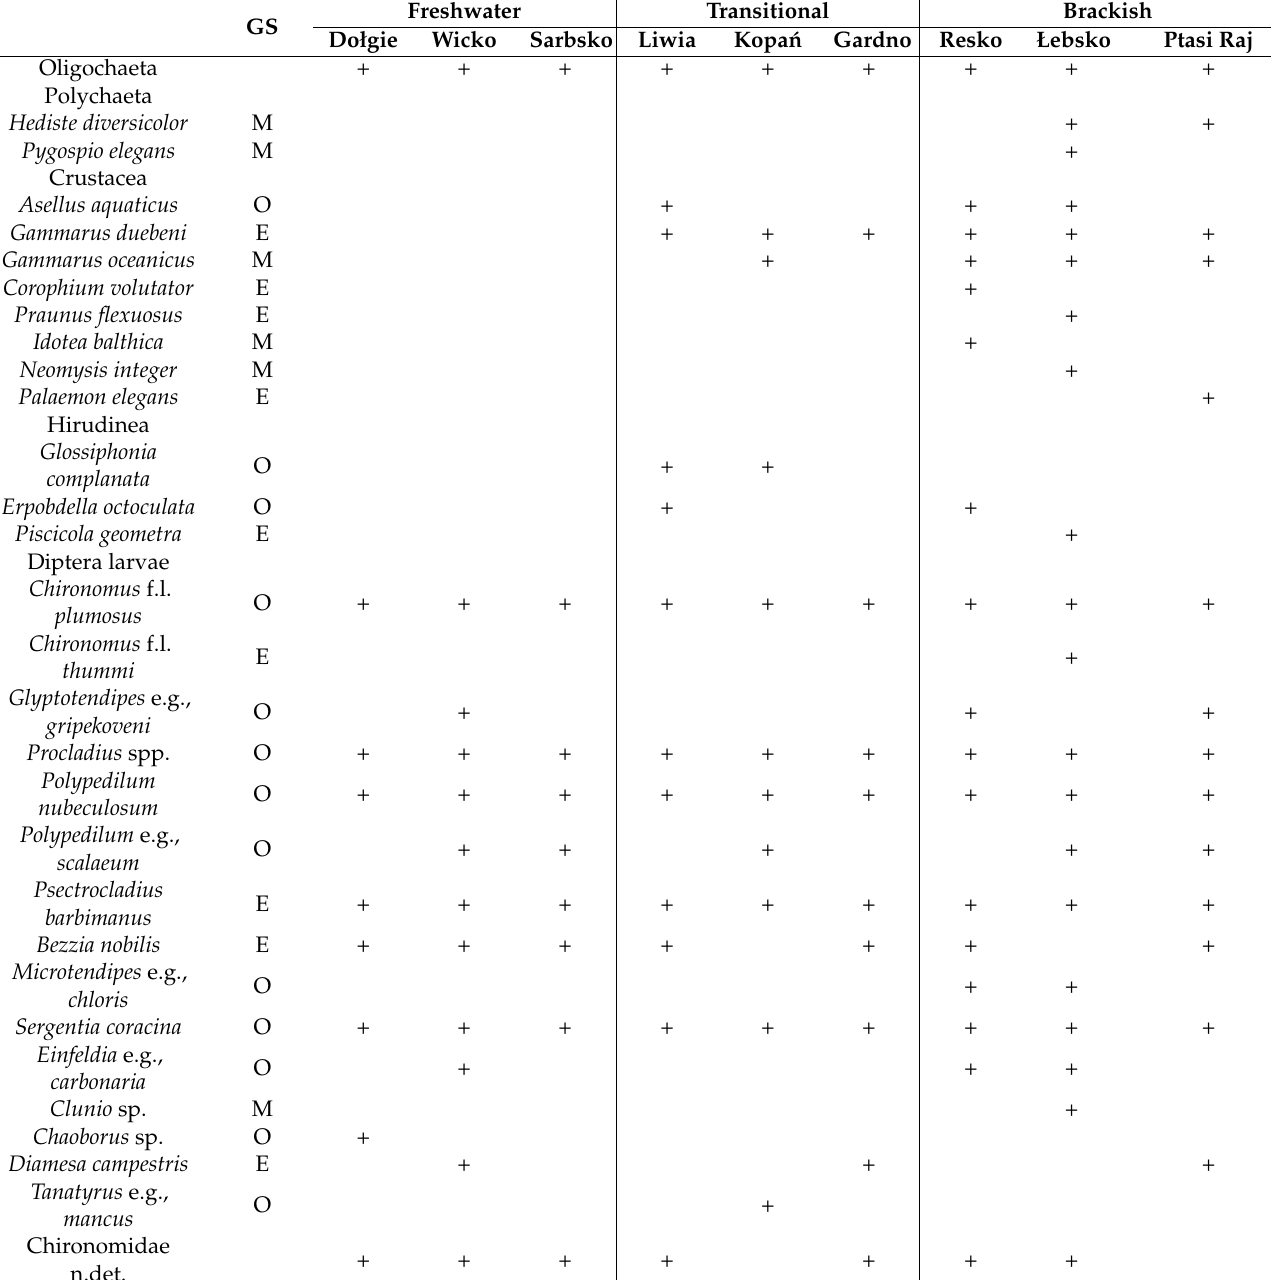
Table 2. The composition of species for each study area (+ the presence of a taxon). GS = Groups of species: O-Opportunistic; E-Euryhaline; M-Marine. Classification according to [17,29,30]. Freshwater Transitional Brackish Dołgie